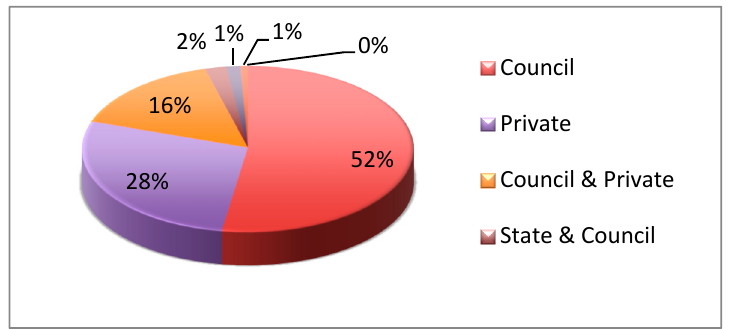
Figure 1. Distribution of ownership structure. Source: own elaboration based on data provided by NVE.